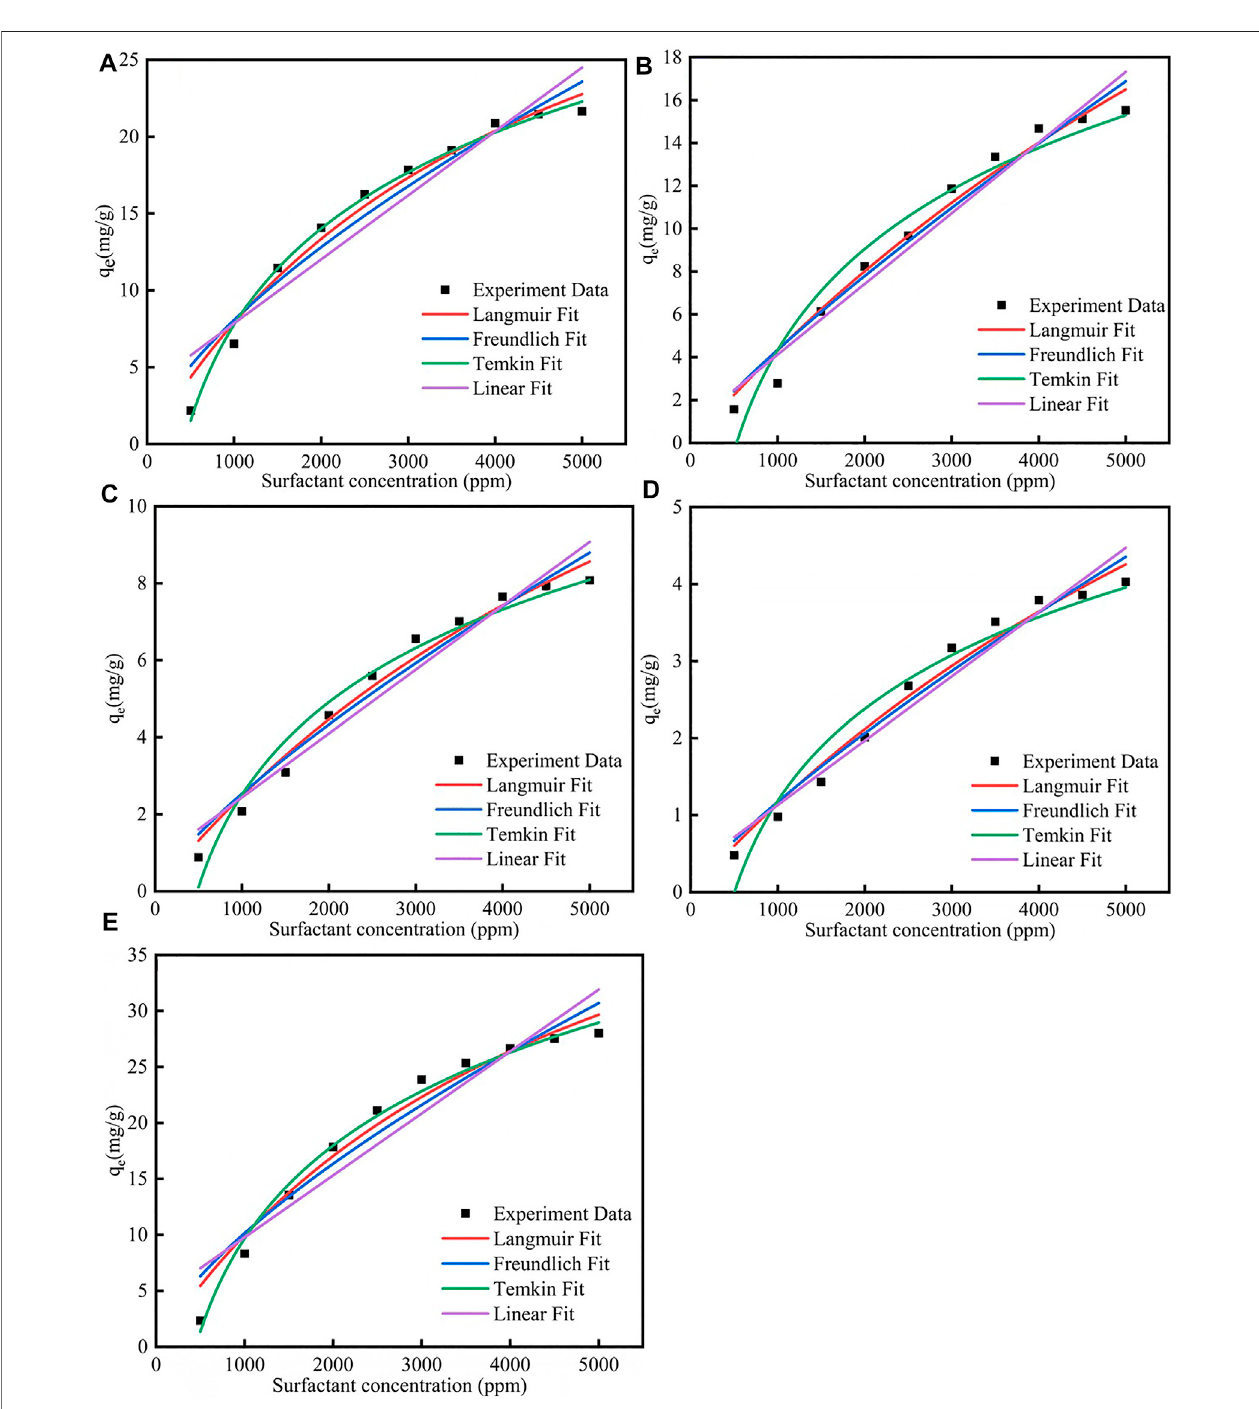
FIGURE 1 | Different isotherm models fi t for adsorption of (A) CTAB, (B) SDS, (C) TX-100, (D) sophorolipid, (E) rhamnolipid on carbonate rock at 298 K.